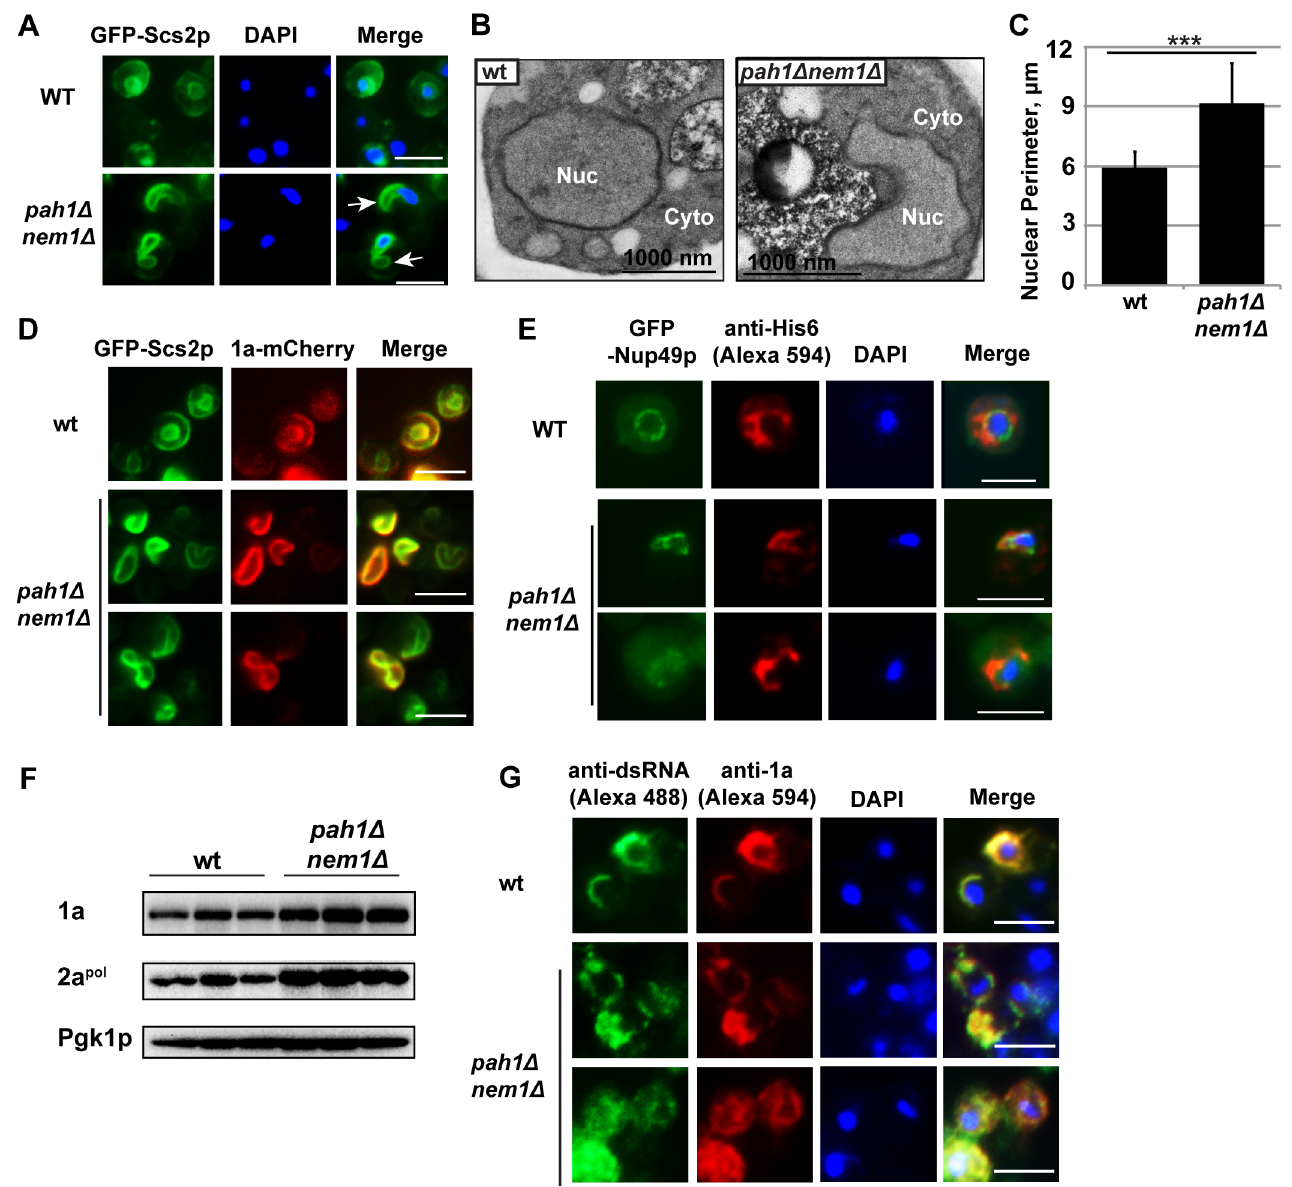
Fig 2. BMV 1a and double-stranded RNA localize to the extended nuclear membrane in pah1 Δ nem1 Δ cells. (A) Epifluorescence microscopic images of the extended nuclear membrane observed in pah1 Δ nem1 Δ cells. GFP tagged Scs2p, an ER membrane protein, represents ER membranes. Nuclei were stained with DAPI. White arrows indicate the extended nER, which is away from DAPI-stained chromosome DNA (blue). (Scale bar, 5μm) (B) Morphology of the nuclear membrane in wt and pah1 Δ nem1 Δ cells under transmission electron microscope. (C) The perimeters of nuclei in wt and pah1 Δ nem1 Δ cells. (cid:3)(cid:3)(cid:3) , p < 0.001 (ANOVA single factor test). (D) Epifluorescence microscopic images showing the localization of 1a in wt and pah1 Δ nem1 Δ cells. The localization of 1a is indicated by mCherry, which is fused to the C-terminus of 1a. The yellow color in merged images represents the co-localization of 1a and Scs2p signals. (Scale bar, 5μm) (E) Immunofluorescence microscopic images showing the localization of 1a-His6 in wt and pah1 Δ nem1 Δ cells. Localization of 1a-His6 was detected using a polyclonal anti-His6 antibody and followed by a secondary anti-rabbit antibody conjugated to Alexa Fluor 594. GFP tagged Nup49p, a component of nuclear pore complexes, indicates the nuclear membrane. Nuclei were stained with DAPI. (Scale bar, 5μm) (F) Accumulated BMV 1a and 2a pol in wt and pah1 Δ nem1 Δ cells. Total proteins were extracted from the same numbers of BMV replicating-yeast cells and analyzed by Western blotting using antibodies specific to 1a and 2a pol . Pgk1p serves as a loading control. (G) Immunofluorescence microscopic images of the co-localization of 1a and dsRNA signals in wt and pah1 Δ nem1 Δ cells. BMV 1a was detected with anti-1a antiserum followed by a secondary anti-rabbit antibody conjugated to Alexa Fluor 594. dsRNA was detected by a dsRNA-specific monoclonal antibody (J2) and a secondary anti-mouse antibody conjugated to Alexa Fluor 488. The yellow color in merged images represents the co-localization of 1a and dsRNA signals. Note 1a and dsRNA appear as a half ring in wt but not in mutant cells. Nuclei were stained with DAPI. (Scale bar, 5μm).